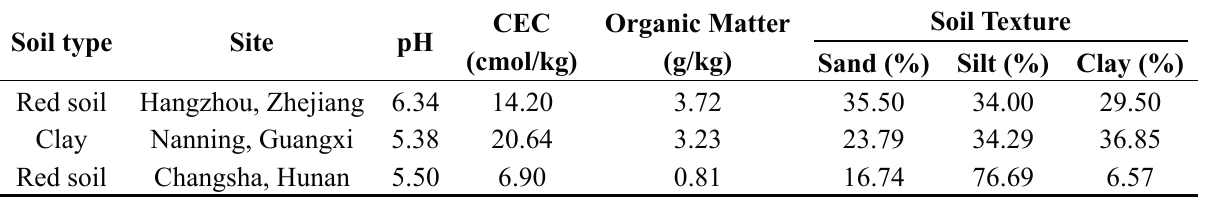
Table 6. Characteristics of orchard soils that were sprayed with glyphosate aqueous solution. Soil